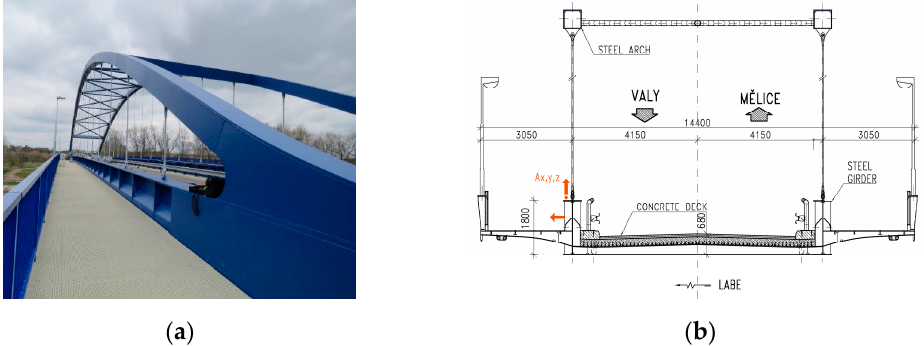
Figure 11. The view on the load bearing structure in the third span of the bridge ( a ) photo; ( b ) schematic with marked positions of accelerometers.